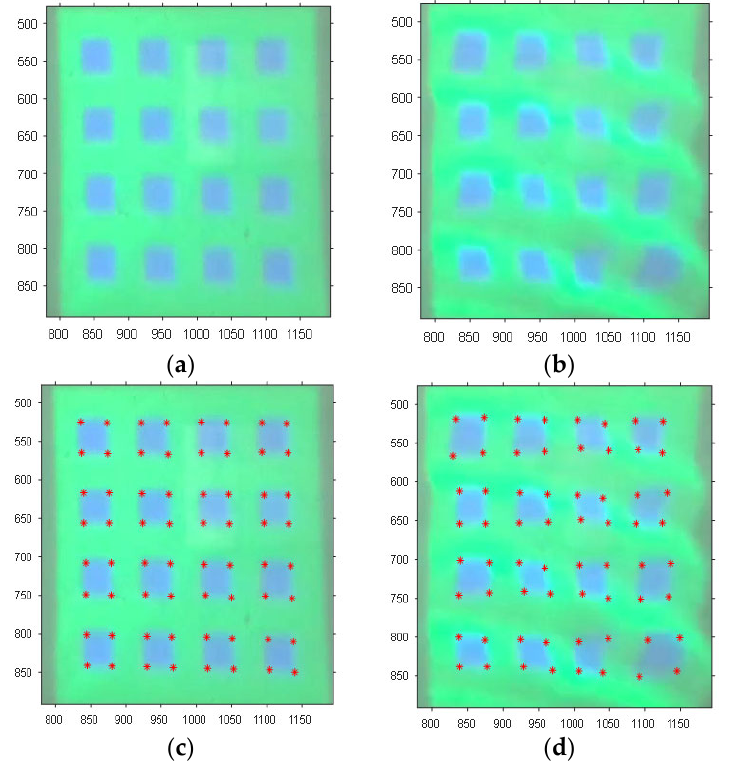
Figure 6. Processing of structured light images in the experiment. ( a ) Reference structured light image for flat water surface. ( b ) Distorted structured light image in the presence of surface waves. ( c ) Feature extraction for the reference frame. ( d ) Feature extraction for the distorted frame.